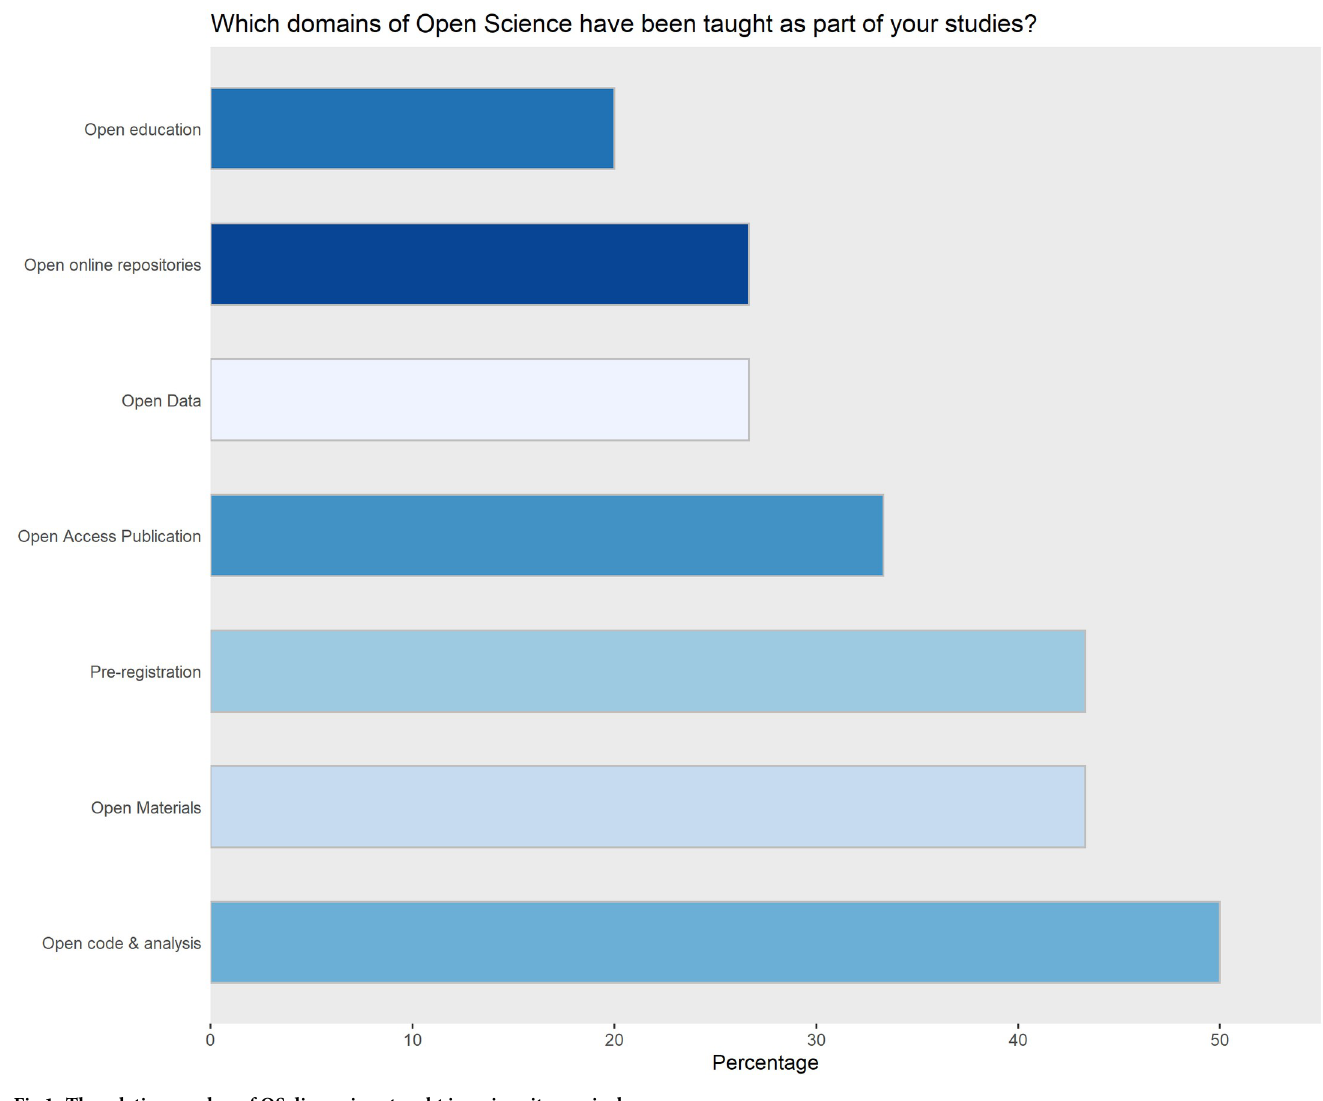
Fig 1. The relative number of OS dimensions taught in university